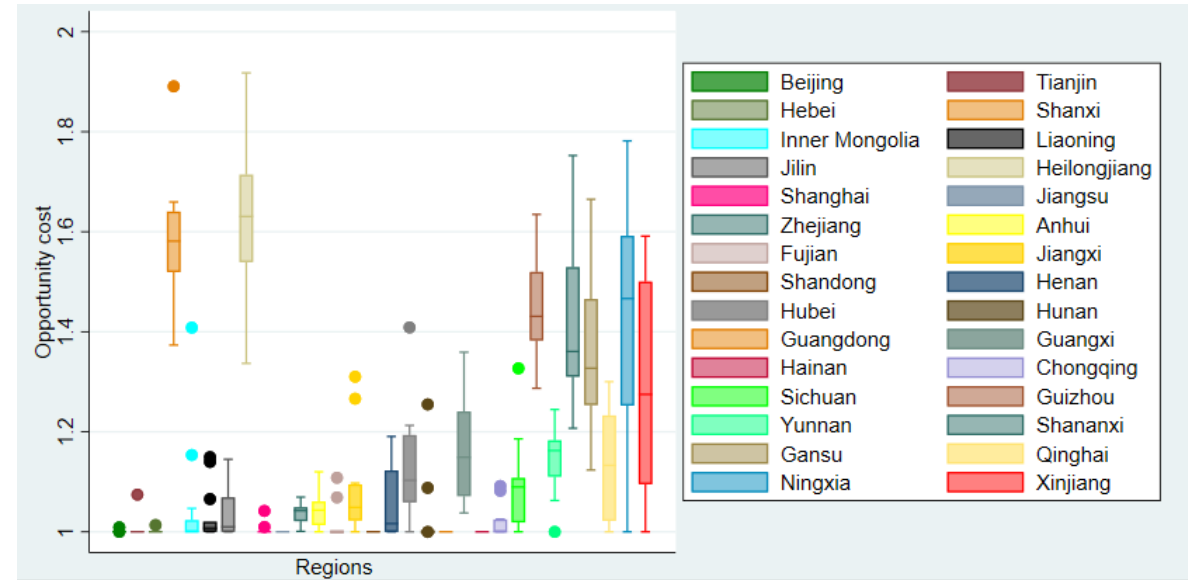
Figure 5. Box plot of opportunity cost from 2003 to 2015 by regions. Note : The horizontal axis represents the industrial sectors in 30 provinces of China and the vertical axis represents the opportunity cost due to environmental regulations during the sample period. The lower and upper hinge of the box present the 25th and 75th percentiles of opportunity cost, the middle line of the boxes represents the median value, and the dots represent outliers.